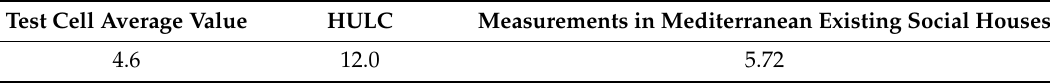
Table 7. Comparison chart of infiltration rates at 50 Pa (n 50 )